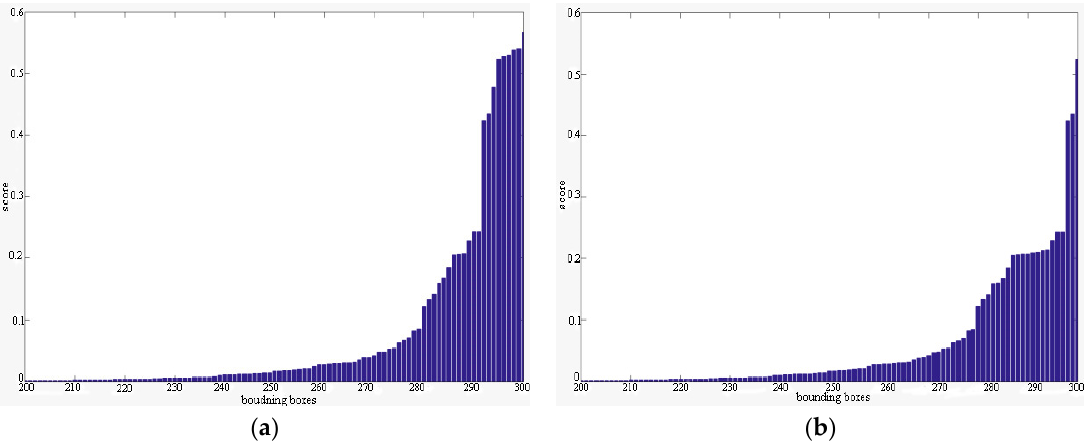
Figure 10. Score distribution of bounding boxes. ( a ) Before improvement; ( b ) after improvement.